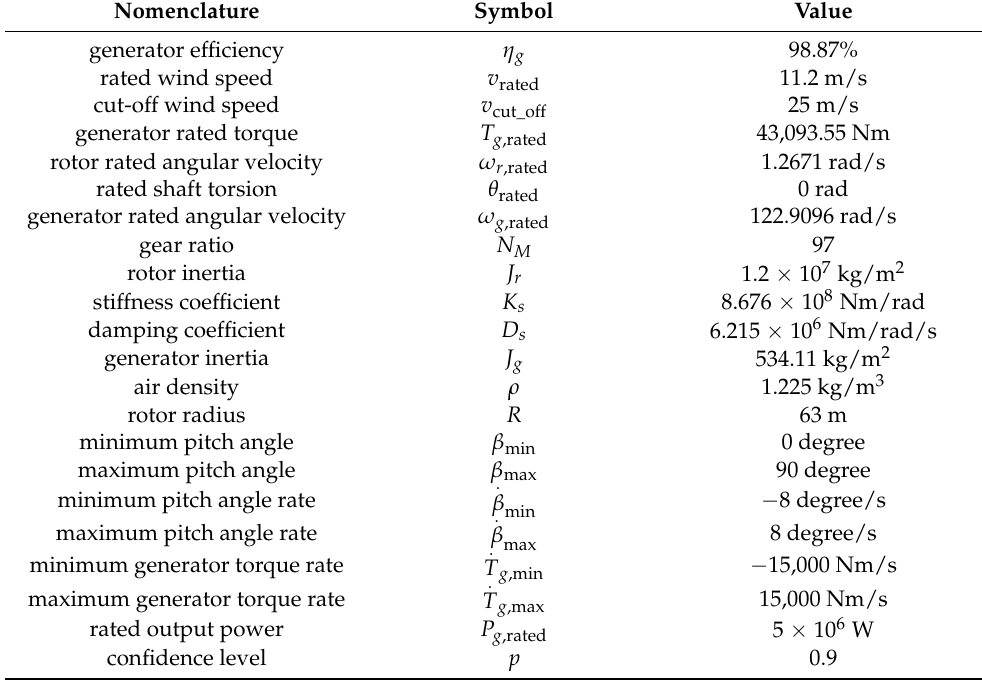
Table 2. The parameters from a 5 MW